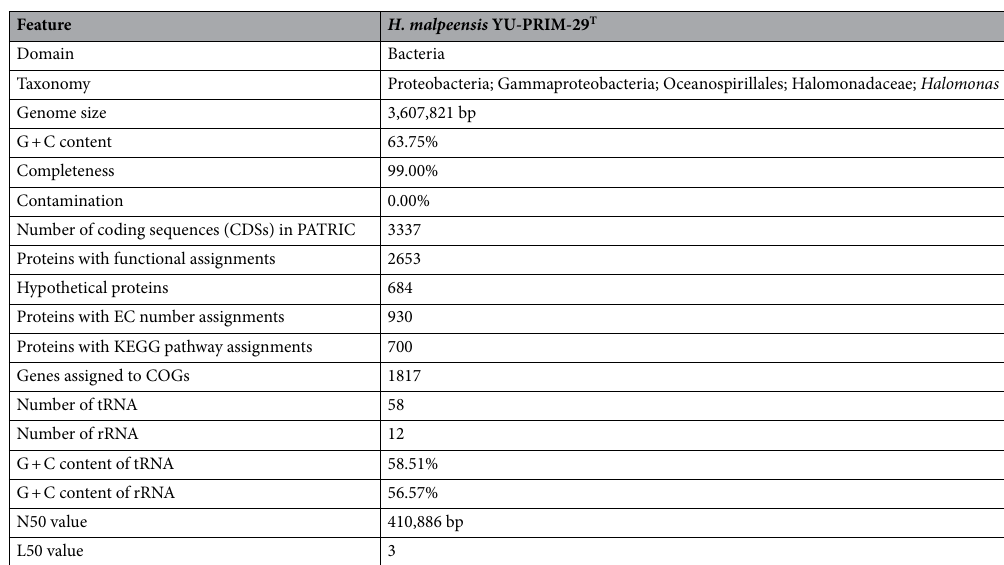
Table 1. General features of the H. malpeensis YU-PRIM-29 T draft